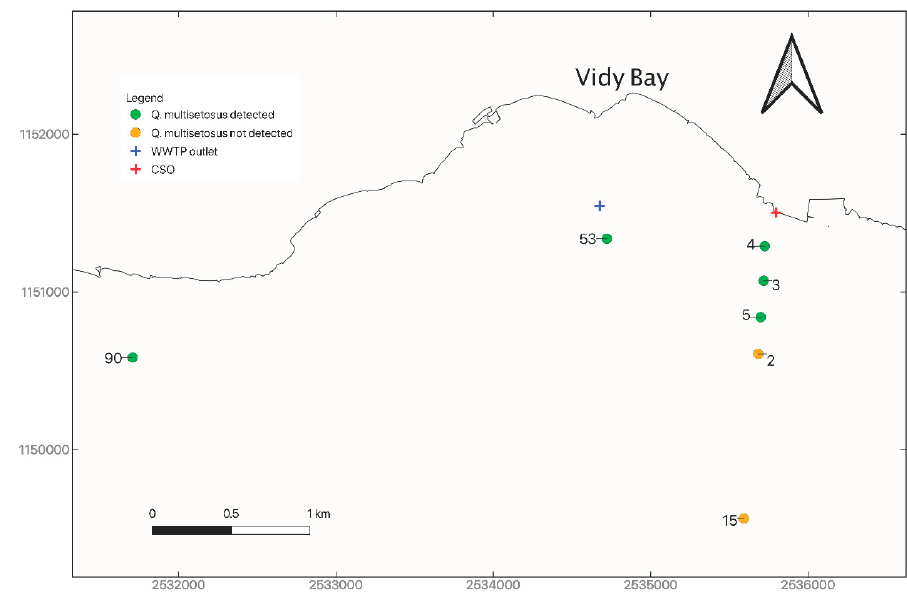
Figure 2. Map showing the presence / absence of Quistadrilus multisetosus at sites 90, 53, 4, 3, 5, 2 and 15. These results are based on both morphological and HTS analyses (concordant results). The wastewater treatment plant (WWTP) outlet and the combined sewer overflow (CSO) are indicated on the